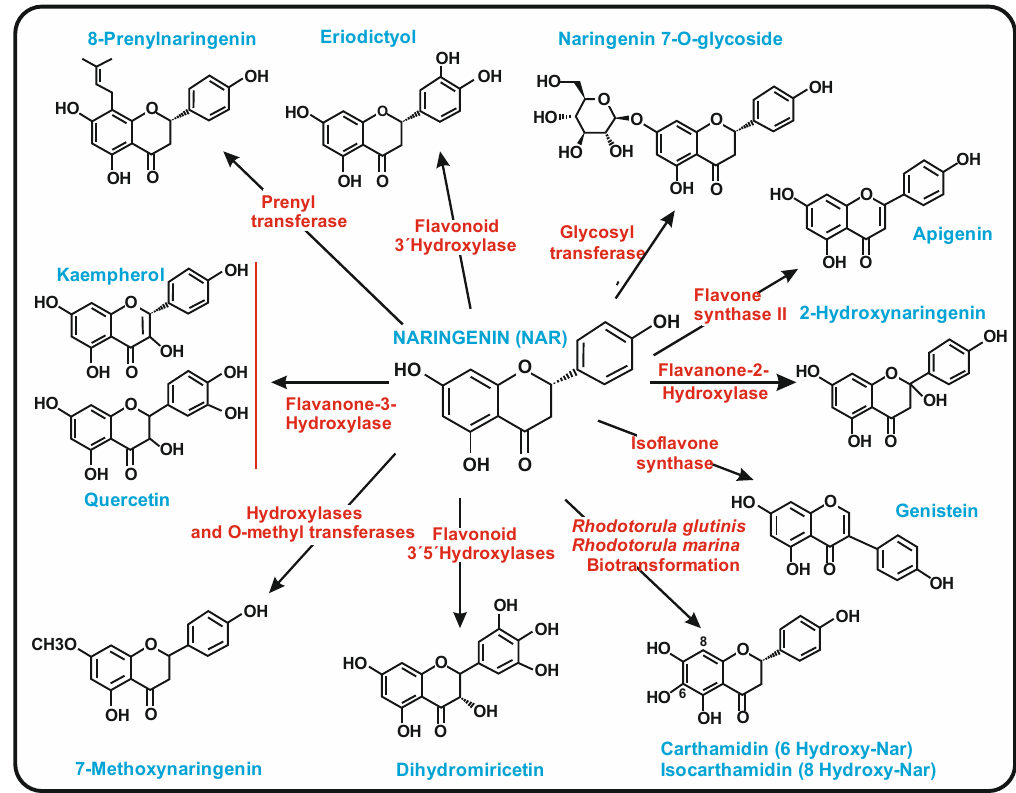
Figure 9. Compounds produced from naringenin using recombinant yeast strains or by biotransfor- mation with species of Rhodotorula. The name of each compound is indicated in blue letters next to its chemical structure. The exogenous enzymes encoded by the recombinant yeasts, or the Rhodotorula species used in the biotransformation, are indicated in red letters.